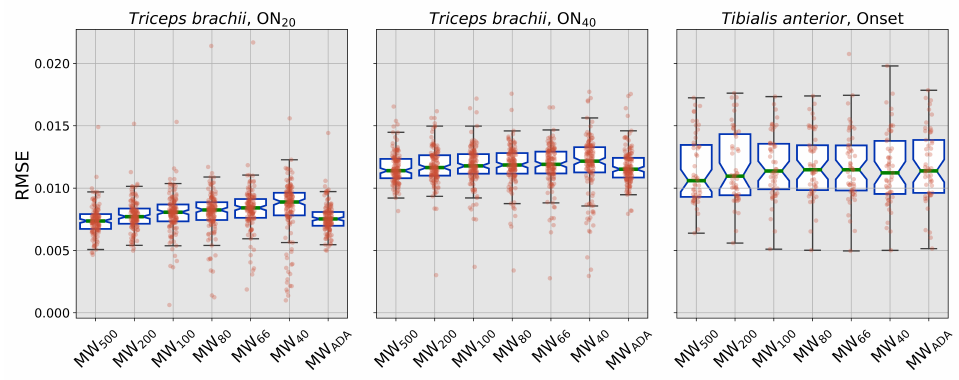
Figure 5. RMSE values. Colors have the same meaning as in Figure